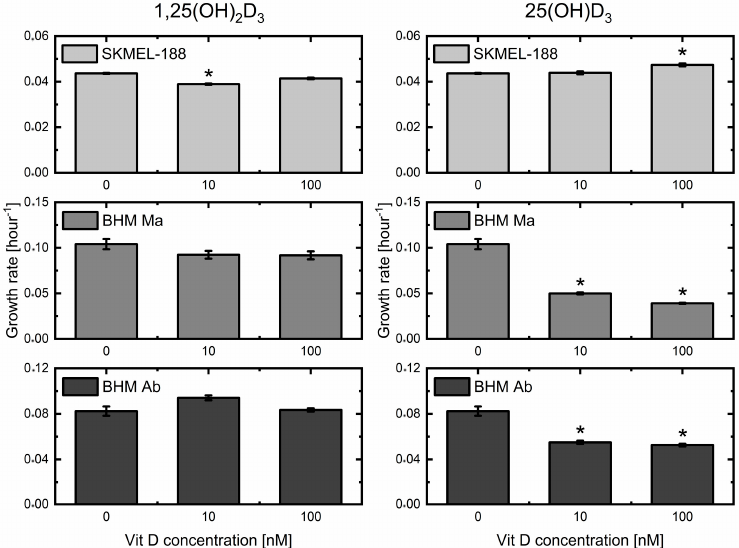
Figure 1. The impact of calcitriol (1,25(OH) 2 D 3 ) and calcidiol (25(OH)D 3 ) on the proliferation of human SKMel-188 and hamster BHM Ma and BHM Ab melanoma cells. Growth rate was calculated from exponential fitting to cell number, counted every 24 h for 4 days in culture. * denotes statistical significance p < 0.05 against control (0 nM of vitamin D 3 derivative).